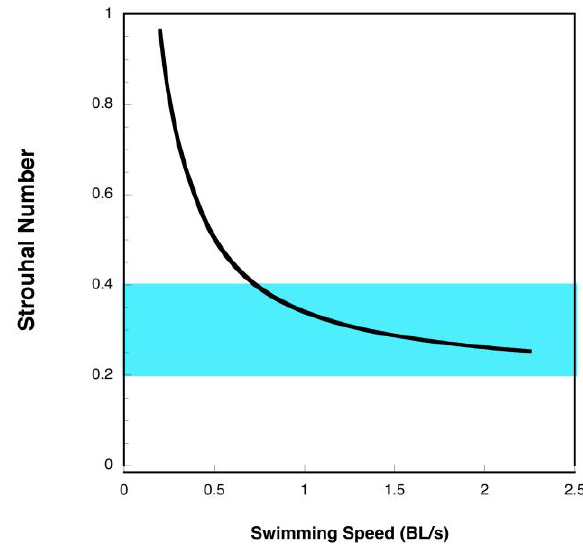
Figure 10. Strouhal number ( St ) as a function of swimming speed. The shaded blue area indicates the region of St = 0.2–0.4, where maximum propulsive efficiency occurs. The line is a fitted curve based on a manta assumed to have a BL = 1.85 m, a flapping frequency from Equation (3), and a heave amplitude of 1.43 m.